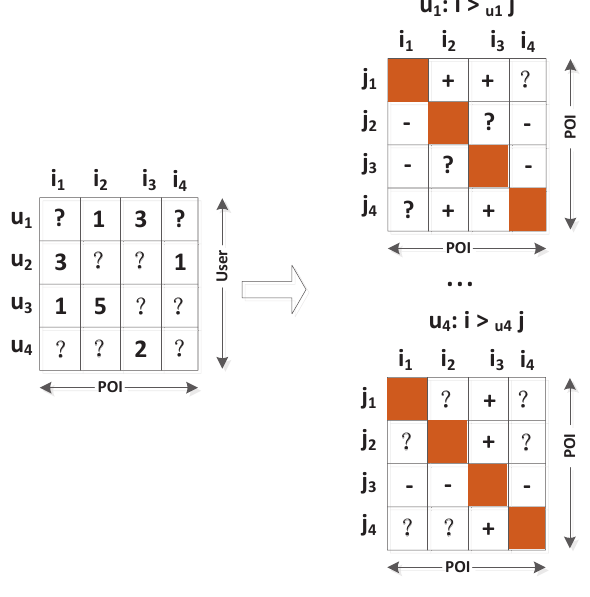
Figure 2. The reconstruct data policy from user-POI visit frequency matrix to pair-wise POI